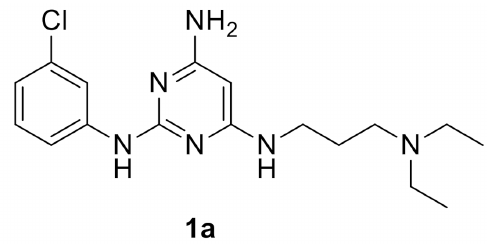
Figure 1. Structure of our previously reported anticancer aminopyrimidine derivative RDS 3442 ( 1a